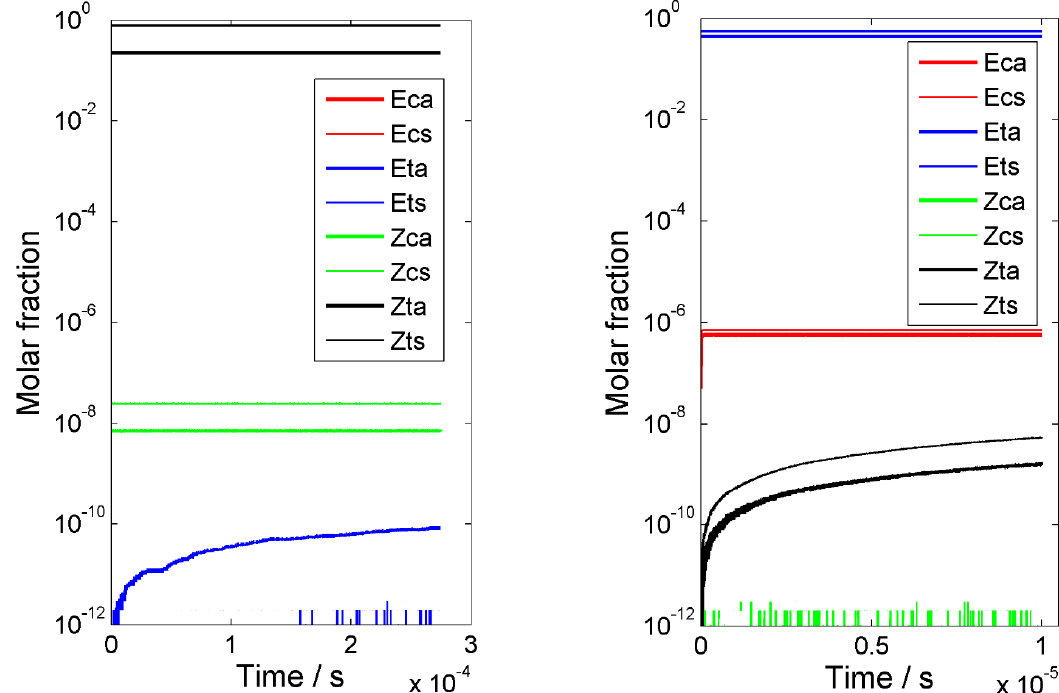
Figure 18. Kinetic Monte Carlo simulations of the 1 -Zt(a,s) → 1 -Et(a,s) ( left ) and 1 -Et(a,s) → 1 -Zt(a,s) ( right ). The molar fraction of each isomer is plotted as a function of time. In the KMC simulation starting from an equilibrium mixture of 1 -Zt(a,s) (Figure 18, left), 1 -Zc(a,s) is first formed. The timescale of the Figure is such that only the station- ary-state concentration of 1 - Zc(a,s) is visible. After ≈10 – 5 s, an increasing population of 1 -Eta develops (the molar fraction of 1 -Ets is very small in the simulation time window). The simulation shows that the dynamics of the 1 -Zt(a,s) → 1 -Eta interconversion are dominated by the process occurring via 1 - Zcγ. By a similar reasoning , based on the KMC simulation starting from an equilibrium mixture of 1 -Et(a,s) (Figure 18, right), we find that 1 -Et(a,s) → 1 -Zt(a,s) is dominated by the process occurring via 1 - Ecγ. Therefore, also occur by different mechanisms involving different intermediates.